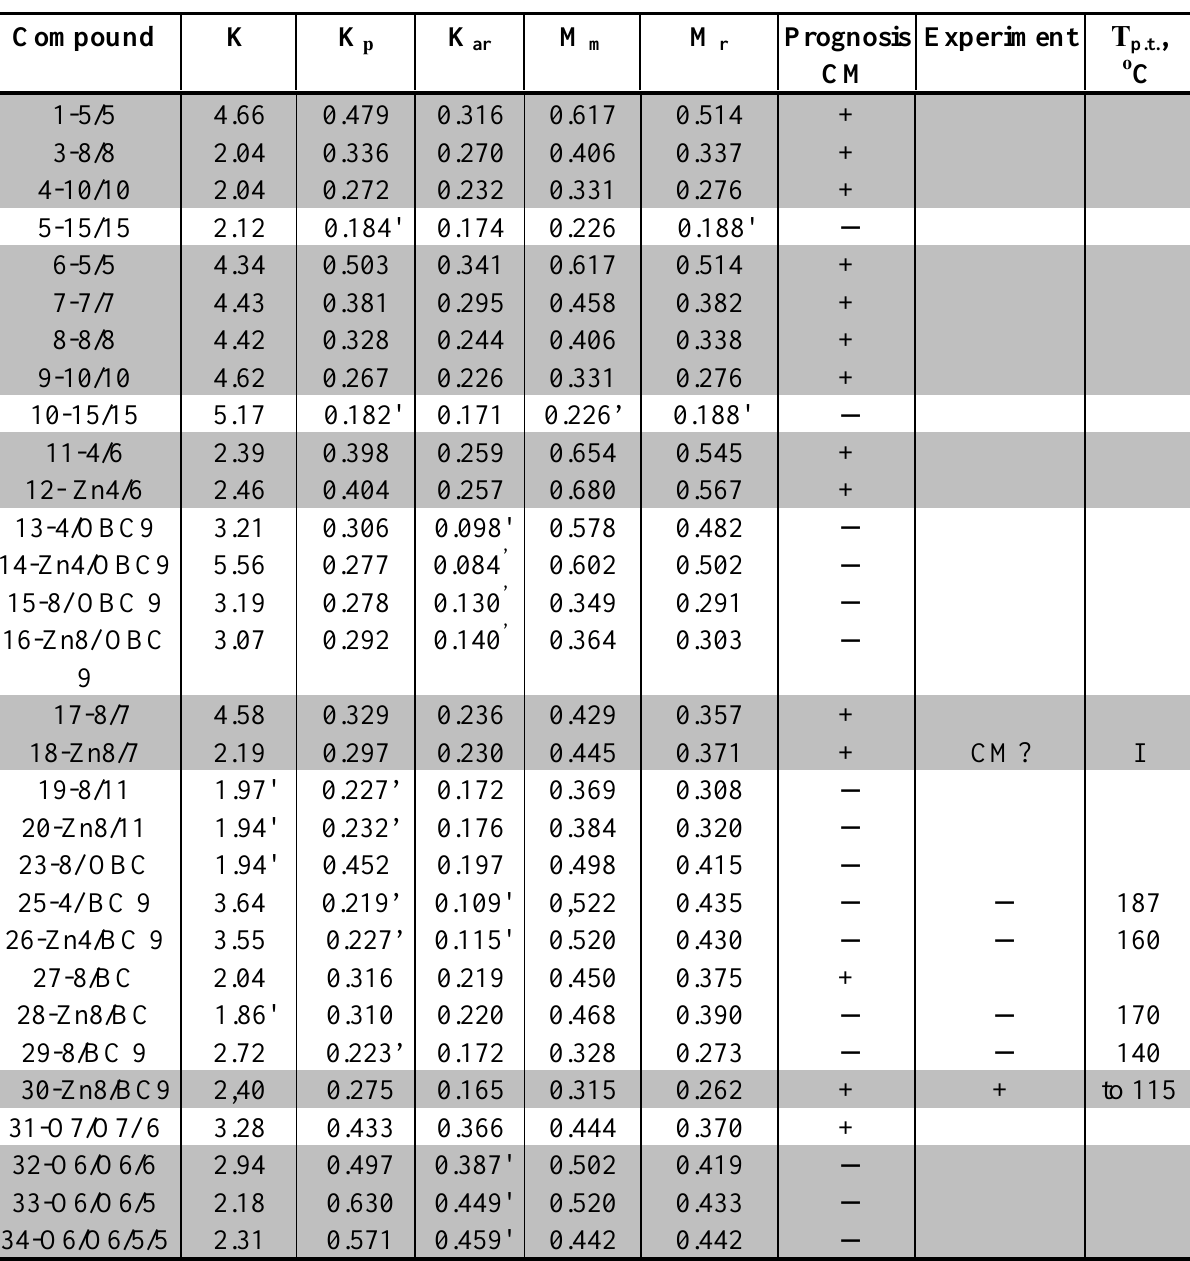
Table 3. Calculated values of molecular parameters of hypothetical structures II [( 1 , 3 - 5 ) R’ =R’’= C H , n = 5, 8, 10, 15; R = H; ( 6-10 ) R’= H, R = R’’ = C n 2n+1 R’ = H, R’’ = C H , n = 4, 8, 16, R = C n 2n+1 R = OC H OC H ; ( 23 ) R’ = H, R’’ = C 6 4 9 19